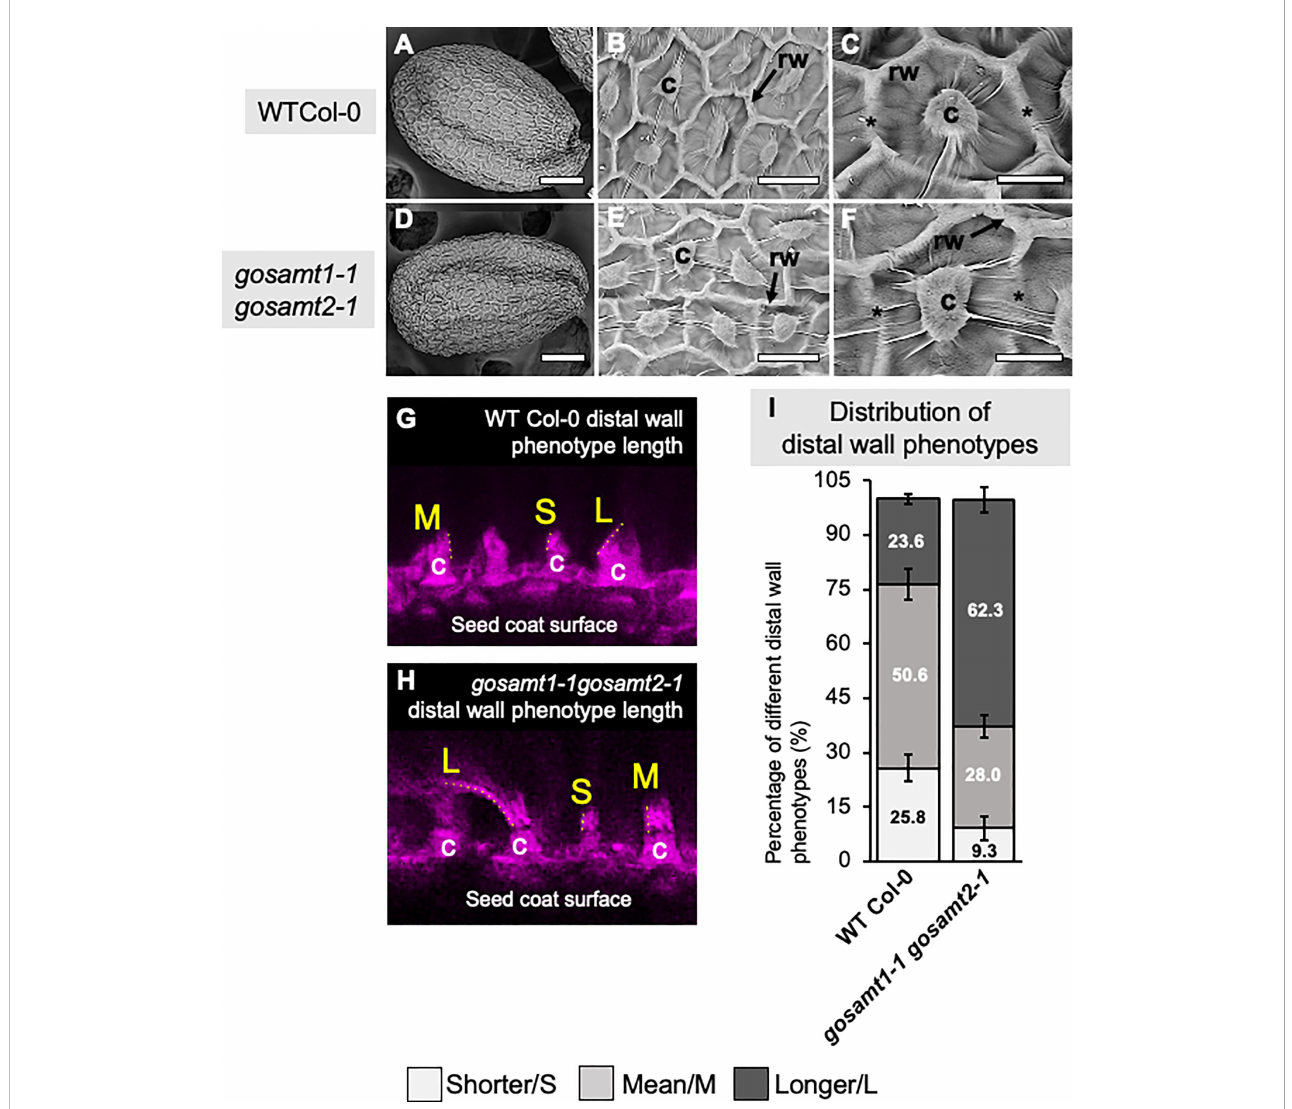
FIGURE 3 gosamt1-1gosamt2-1 seed coat epidermal cell morphology is affected and cell-wall breakage is altered. (A – F) Scanning electron micrographs (SEM) of WT-Col-0 and gosamt1-1gosamt2-1 seeds surfaces under different magni fi cations. Scale bars A and D = 100 m m, B and E 25 µm, and C and F= 10 µM; stars indicate differences between WT Col-0 and the gosamt1-1gosamt2-1 mutant line. (G, H) Images of different distal wall phenotypes after breakage (i.e., S = short; M = mean; L = long) stained with Pontamine fast scarlet (pink). (I) Percentage quanti fi cation of S, M, and L distal-wall phenotype in gosamt double mutant compared to WT Col-0. Error bars represent SE from three biological replicates ( n = 300 –